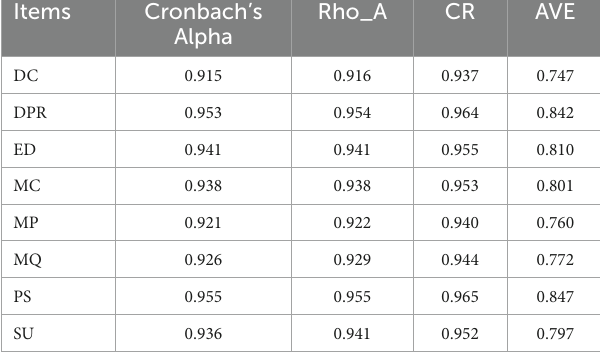
TABLE 3 Reliability and validity